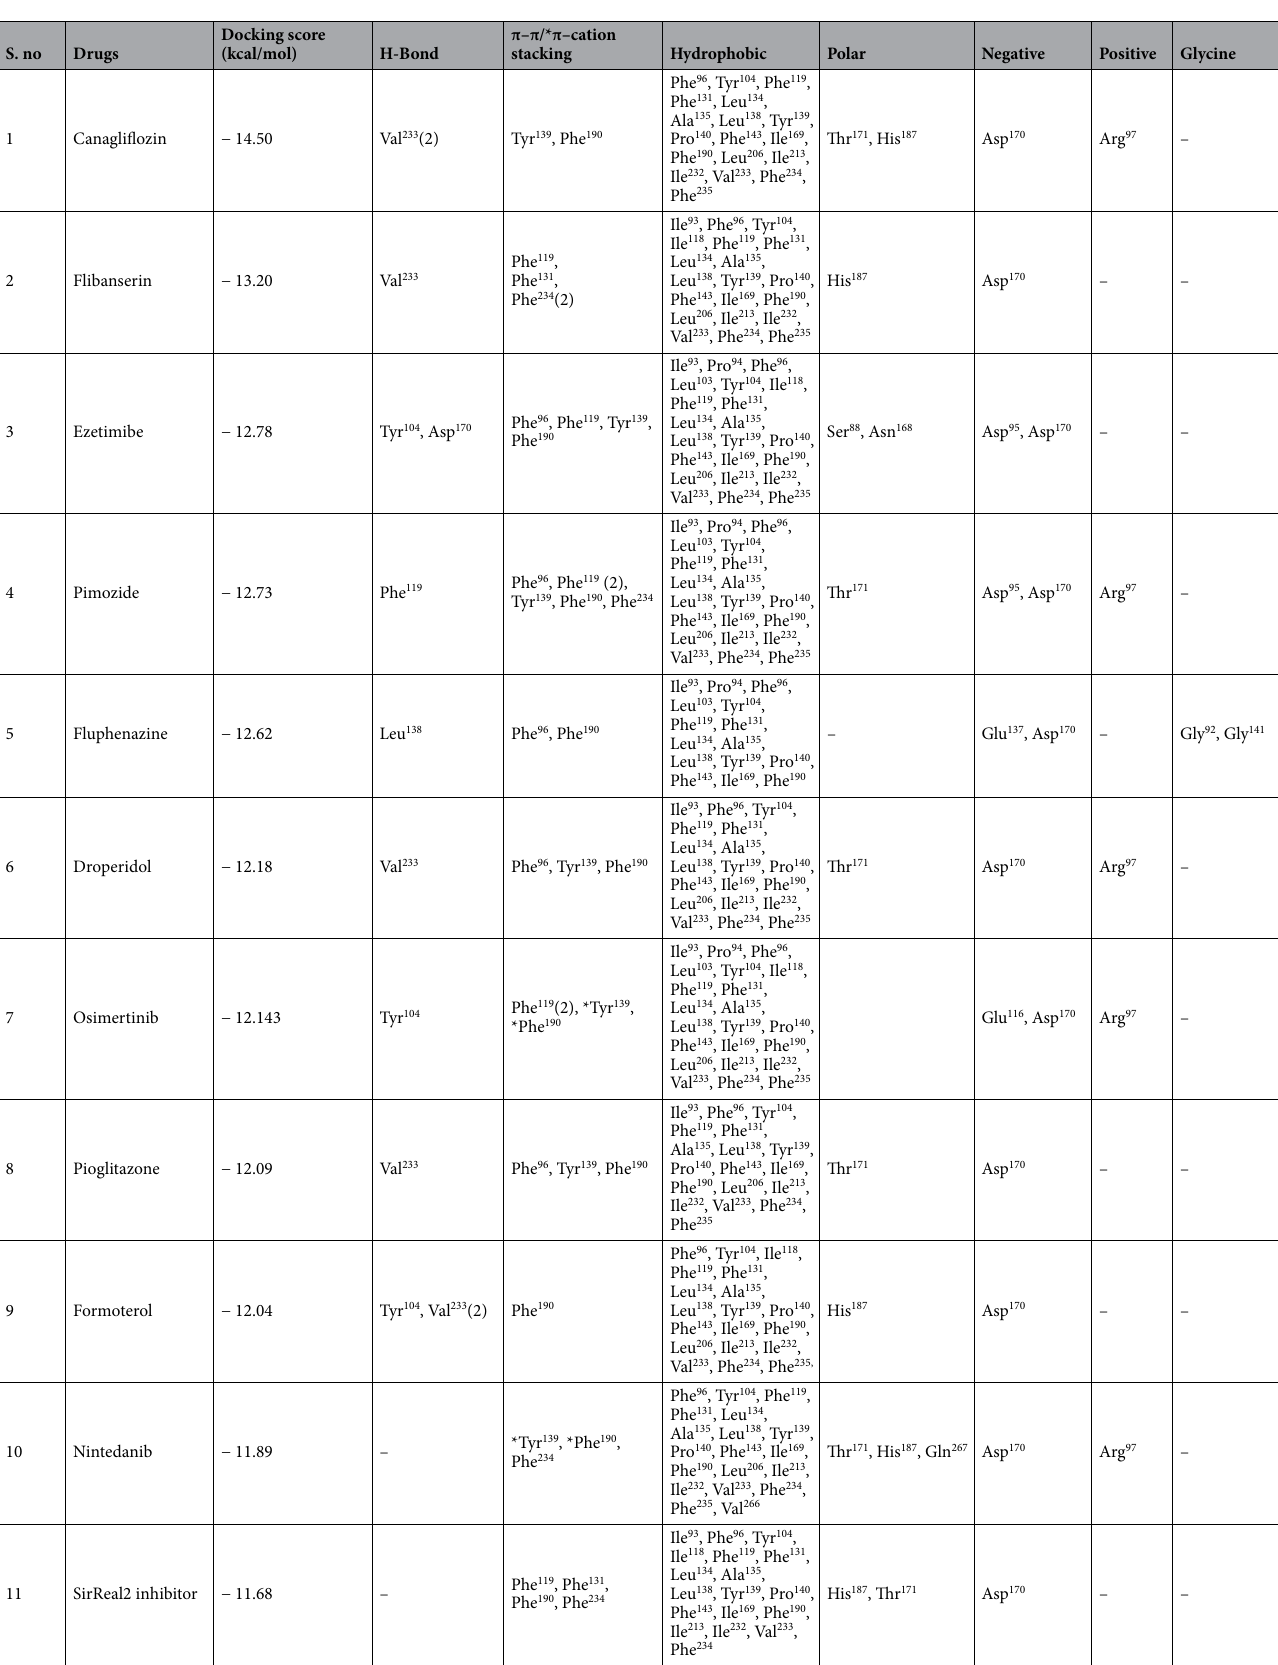
Table 1. Docking scores and molecular contact profiling for the docked FDA-approved drugs in the selective pocket of